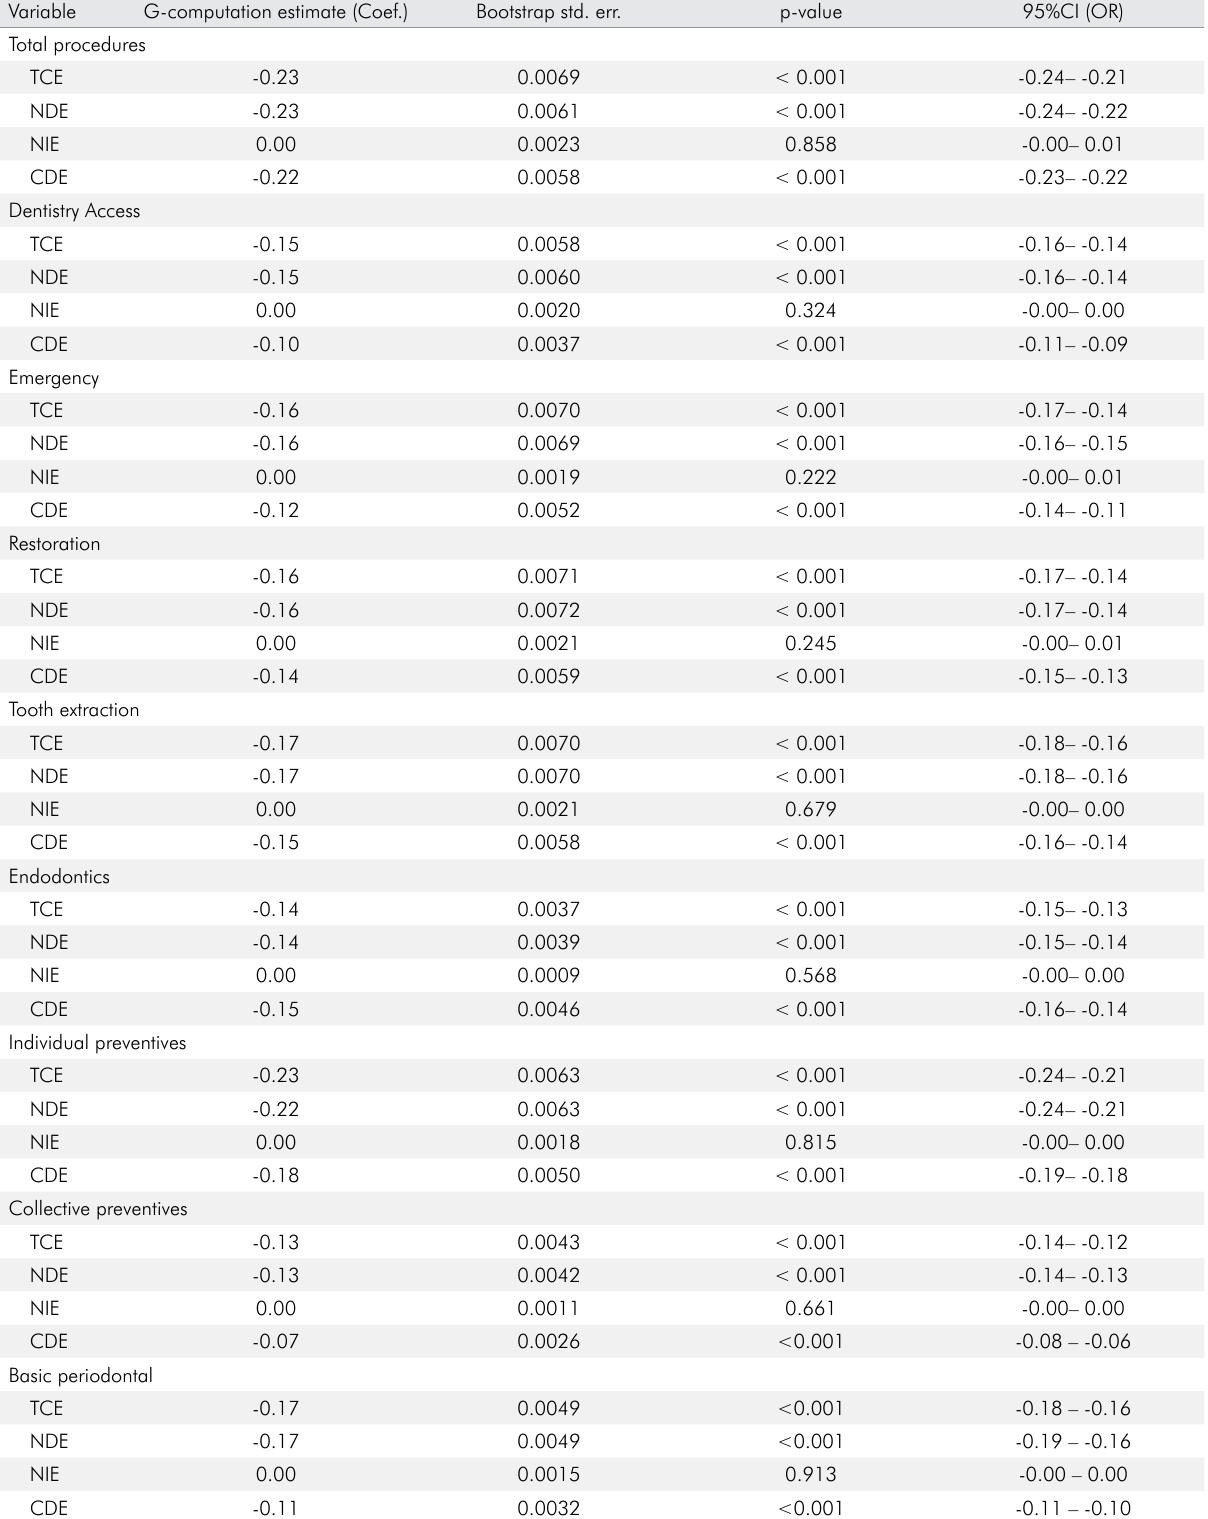
Table 6. G-computation analysis of dentistry services restriction as a mediator in the association between COVID-19 pandemic (from the March 2020 to August 2020) and dentistry procedures in Brazilian Public Services. (n = 5,564).